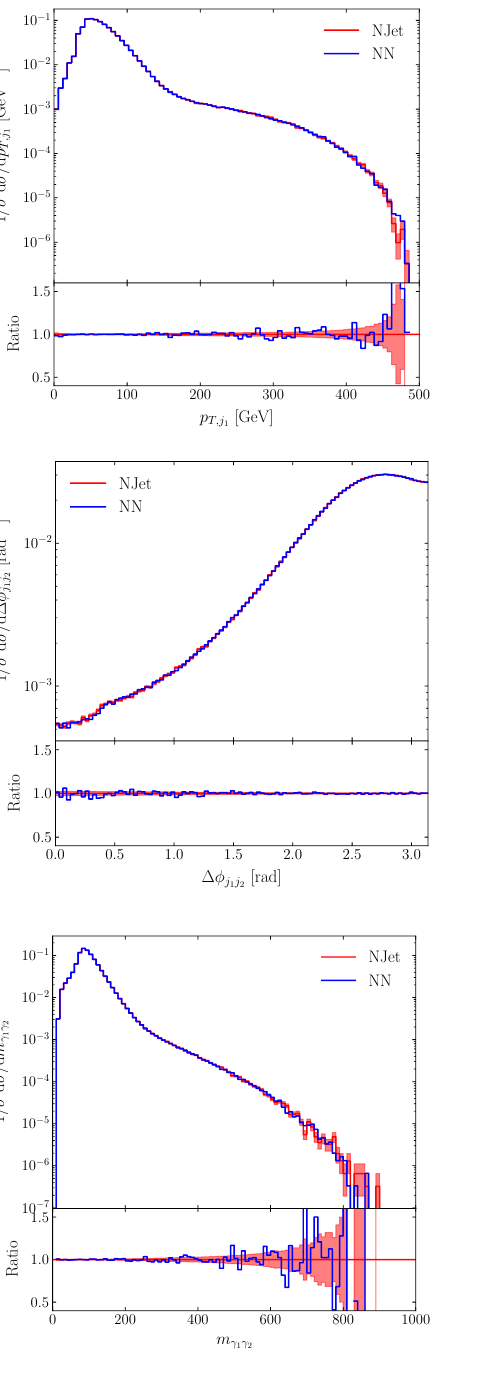
Figure 8. Differential distributions normalised to the cross section for the 2 → 4 process comparing NJet (red) with the NN ensemble (blue). The NJet results are quoted with MC errors, and the NN results with precision/optimality uncertainties calculated as described in ref. [60] but which are negligible in